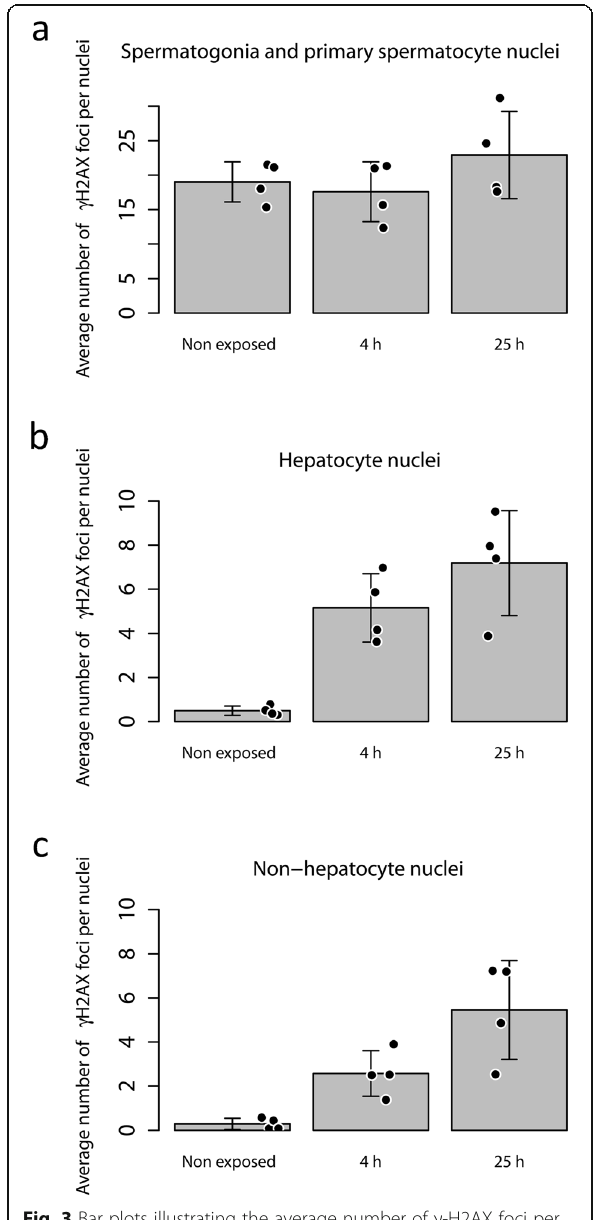
Fig. 3 Bar plots illustrating the average number of γ -H2AX foci per cell nuclei for different groups of animals (non-exposed, 4 h P.I., and 25 h P.I.) for the a spermatogonia and primary spermatocytes, b hepatocytes, and c non-hepatocytes. The mean value for each individual animal within a group is illustrated by a black dot. The points have been randomly displaced along the horizontal axis to increase visibility; it should not be interpreted as a variation in time after